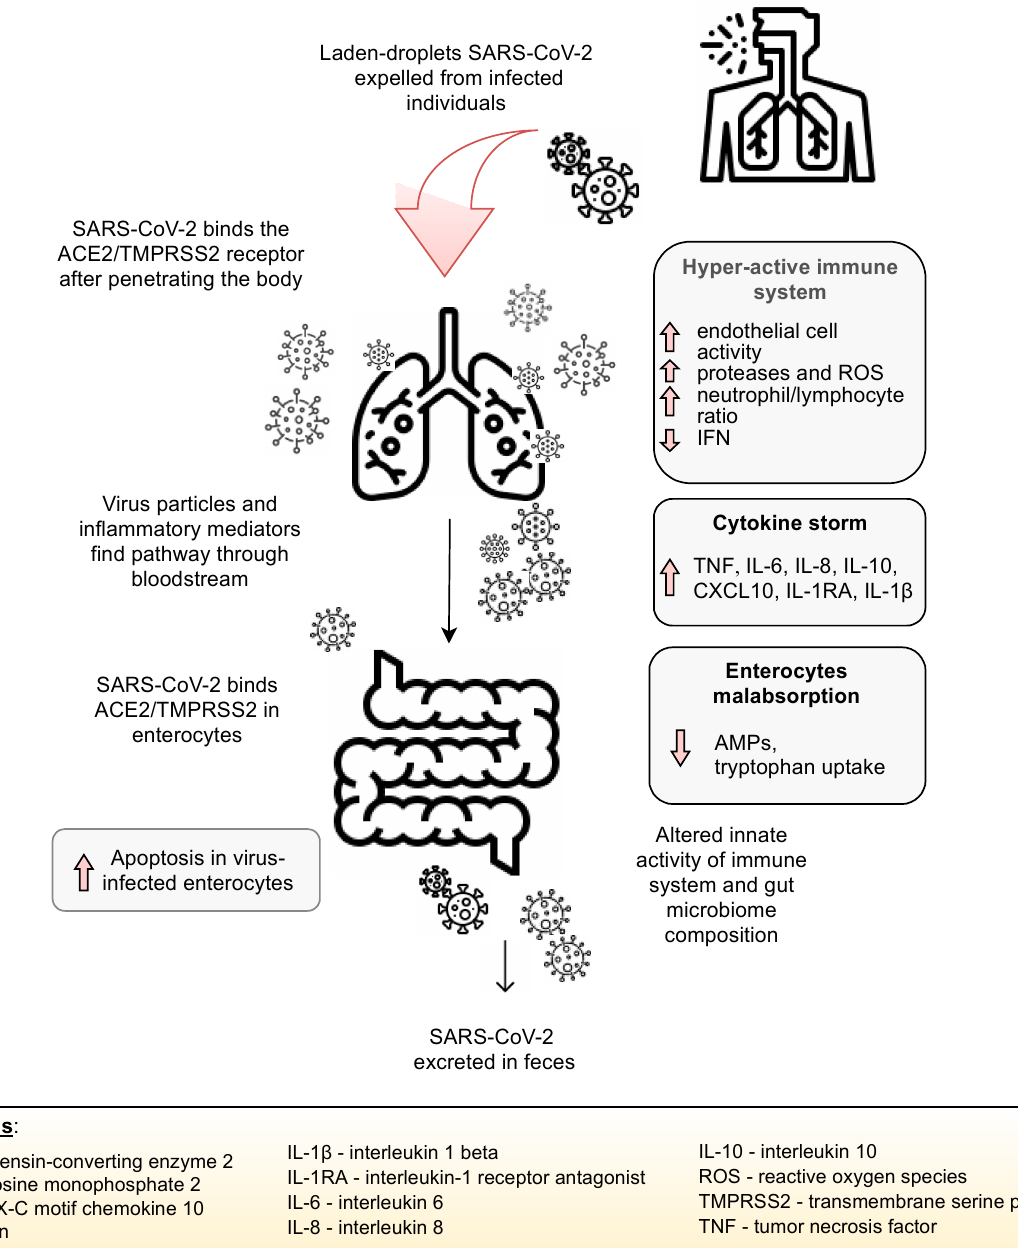
Figure 3. The potential mechanism of the involvement of the gut–lung axis in SARS-CoV-2 infection. Inhalation of viral-laden droplets expelled from an infected individual may lead to the binding of SARS-CoV-2 molecules to the ACE2 enzyme and other receptors and entry into potential host cells. Stimulation of the host immune system leads to the re- lease of inflammatory mediators and, consequently, may lead to a “cytokine storm”. Elevated concentrations of inflammatory mediators lead to the activation of endothelial cells and lung hyperpermeability; thus, SARS-CoV-2, along with inflammatory mediators, migrates to the gut via circulation and binds to ACE2 receptors expressed on enterocytes to influence the microbial structure and immune system. Inflammatory mediators disrupt the intestinal barrier, increasing gut permeability, resulting in the entry of microorganisms and their metabolites into circulation, enabling its migration to various organs, including the lungs